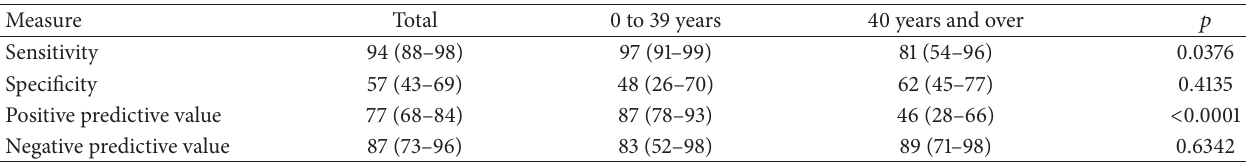
Table 3: Diagnostic performance of the administrative data algorithm for the identification of primary spontaneous pneumothorax cases (estimate and 95% confidence